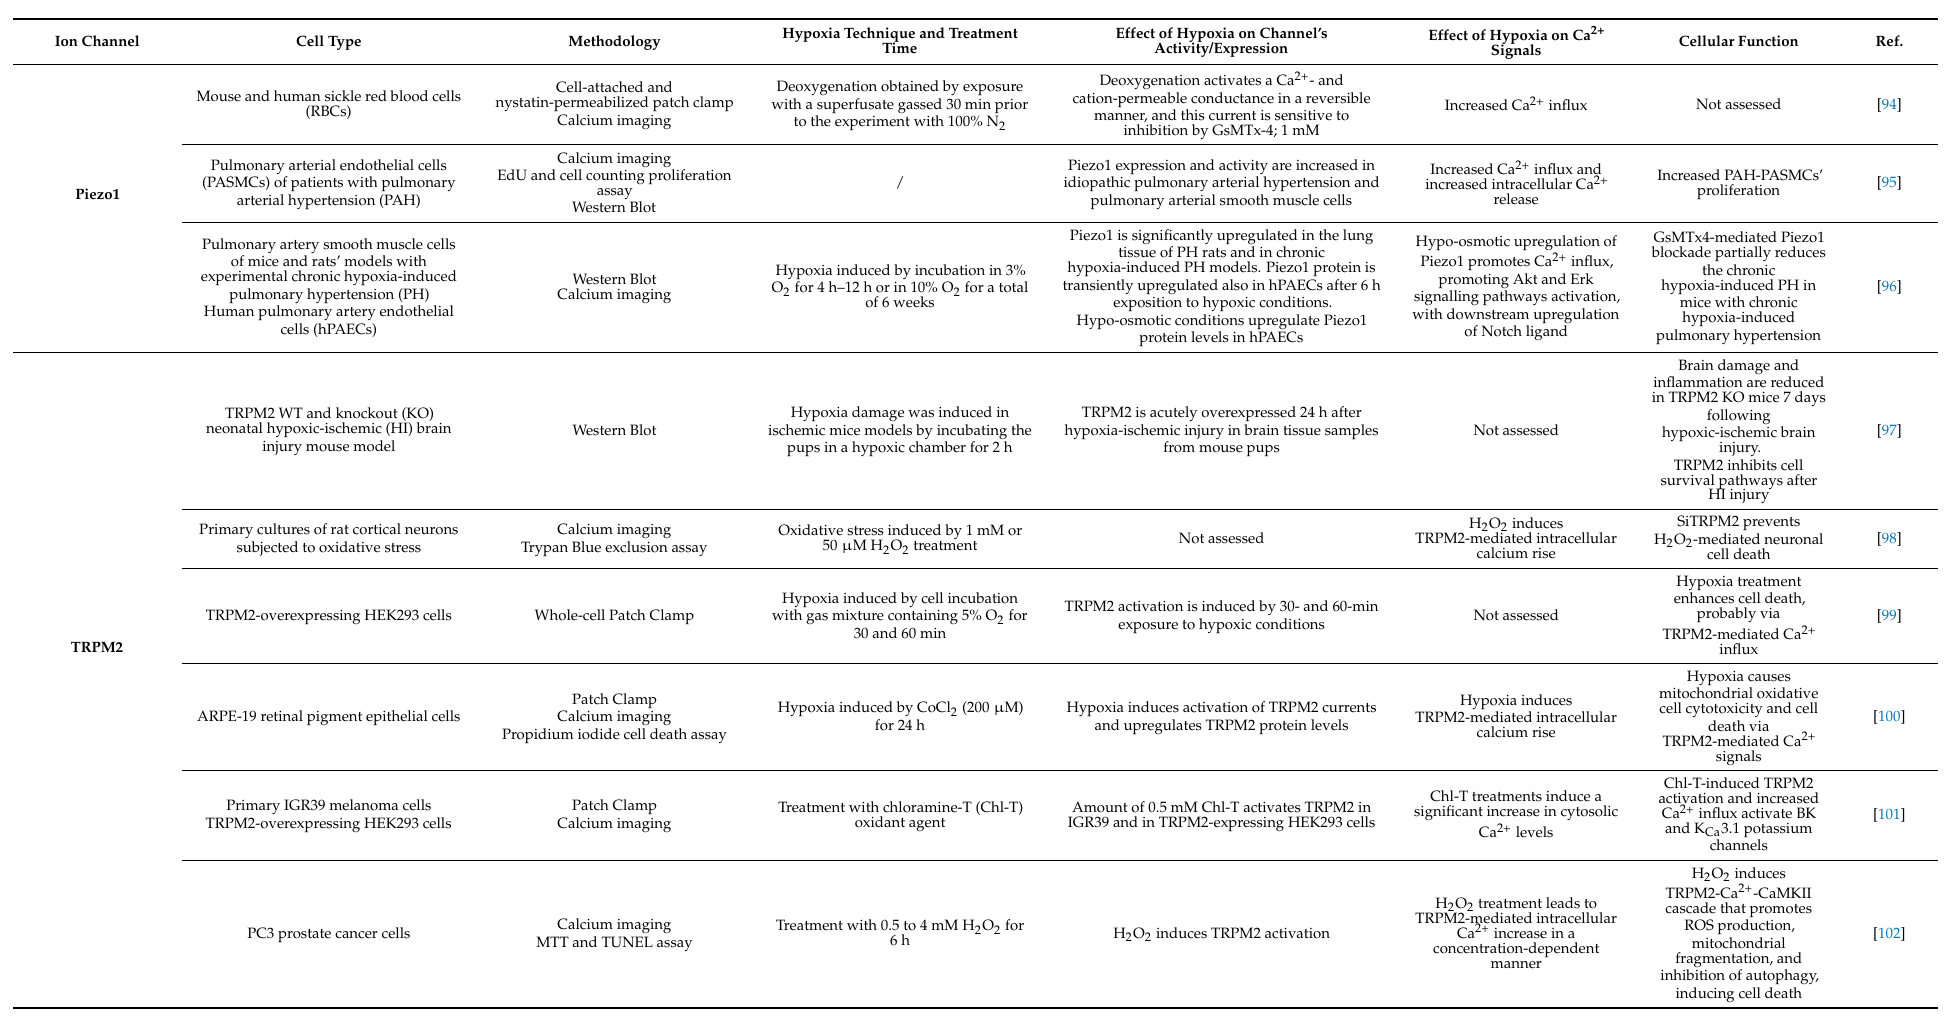
Table 2. Ca 2+ -permeable ion channels regulation by